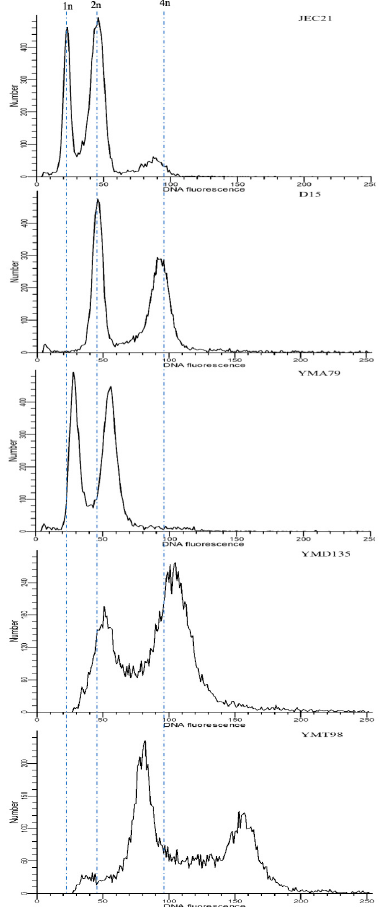
Figure 2. Three different ploidy levels were observed among progeny. Fluorescence-activated cell sorting (FACS) profiles of haploid control JEC21 (1n), diploid control D14 (2n), likely aneuploid progeny YMA79 (between 1n and 2n), likely diploid progeny YMD135 (2n), and likely triploid progeny YMT98 (between 2n and 4n) are shown here. 1n, 2n, and 4n indicate nuclear DNA content. The x -axis shows the relative fluorescence intensity of DNA content, and the y -axis represents the number of the counted cells of each fluorescence intensity